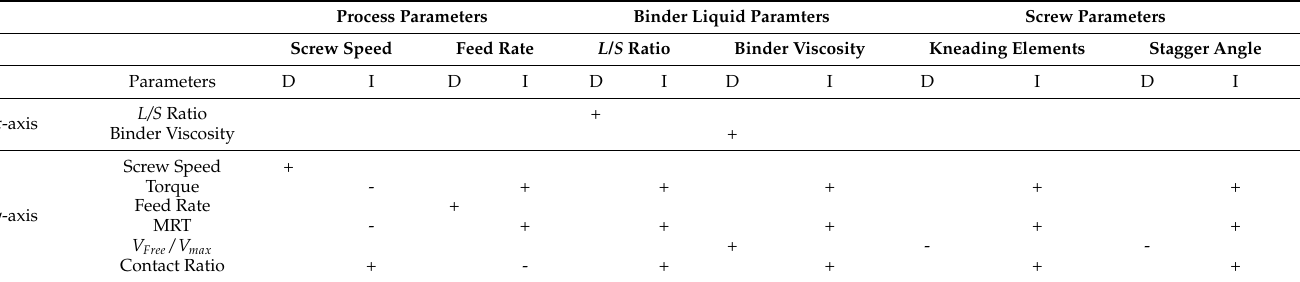
Figure 6. The influence of the process and the screw parameters on the regime map. Table 3. Influence of the process and screw parameters on the important x -axis and y -axis parameters. (’D’ indicates direct effect, ’I’ indicates indirect effect, ’+’ indicates increasing trend and ’-’ indicates decreasing